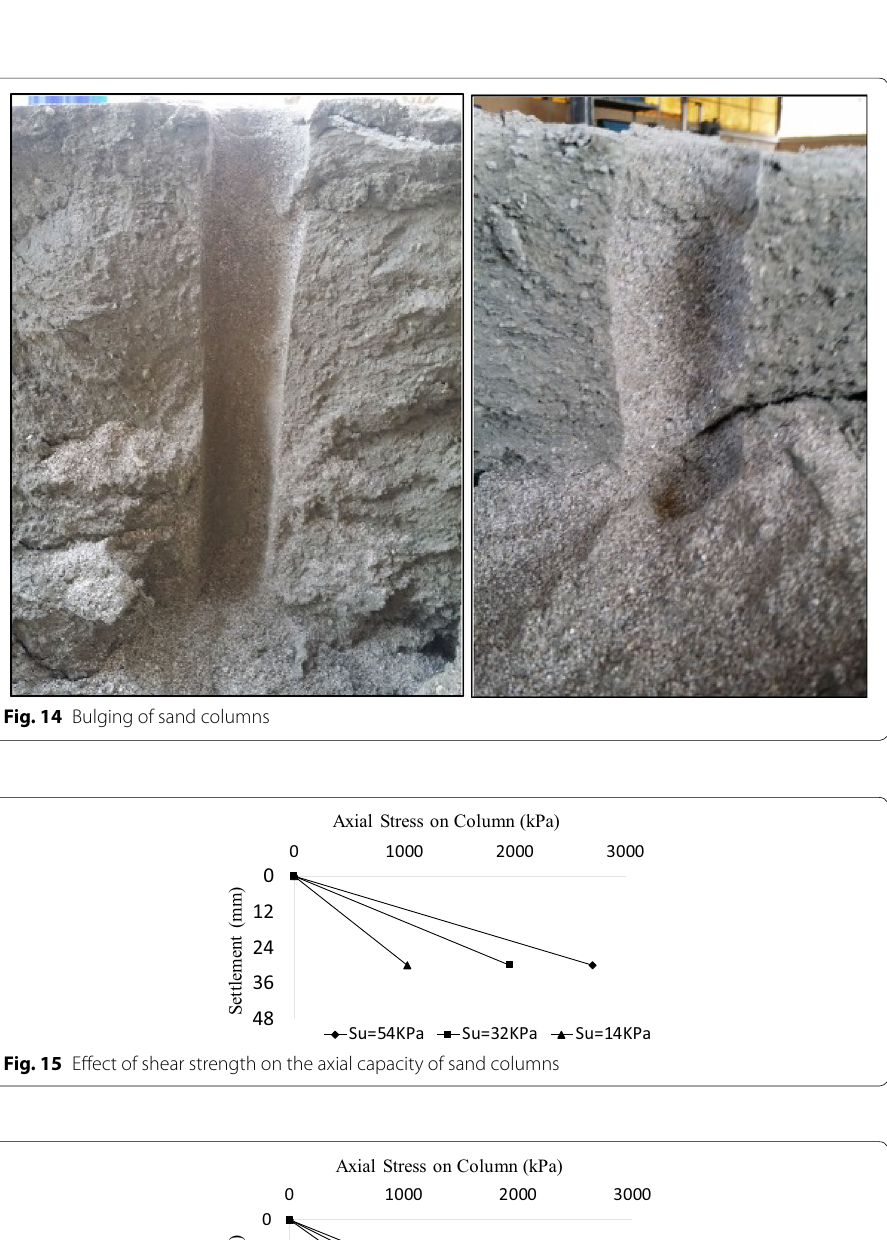
Fig. 16 Effect of L/D ratio on the axial capacity of sand